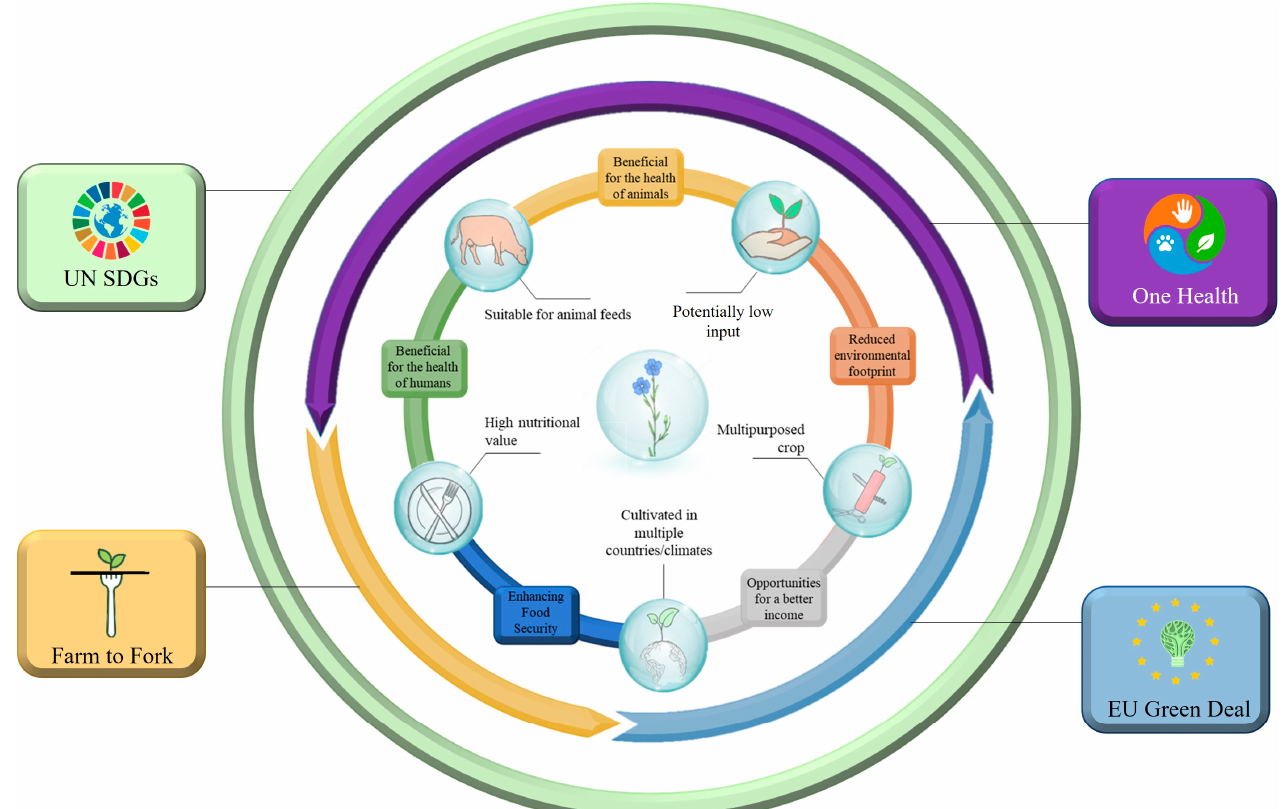
Figure 2. The benefits that flax offers to the environment, the humans, and the livestock. These benefits are depicted under the context of the current agricultural policies that the EU has committed to.